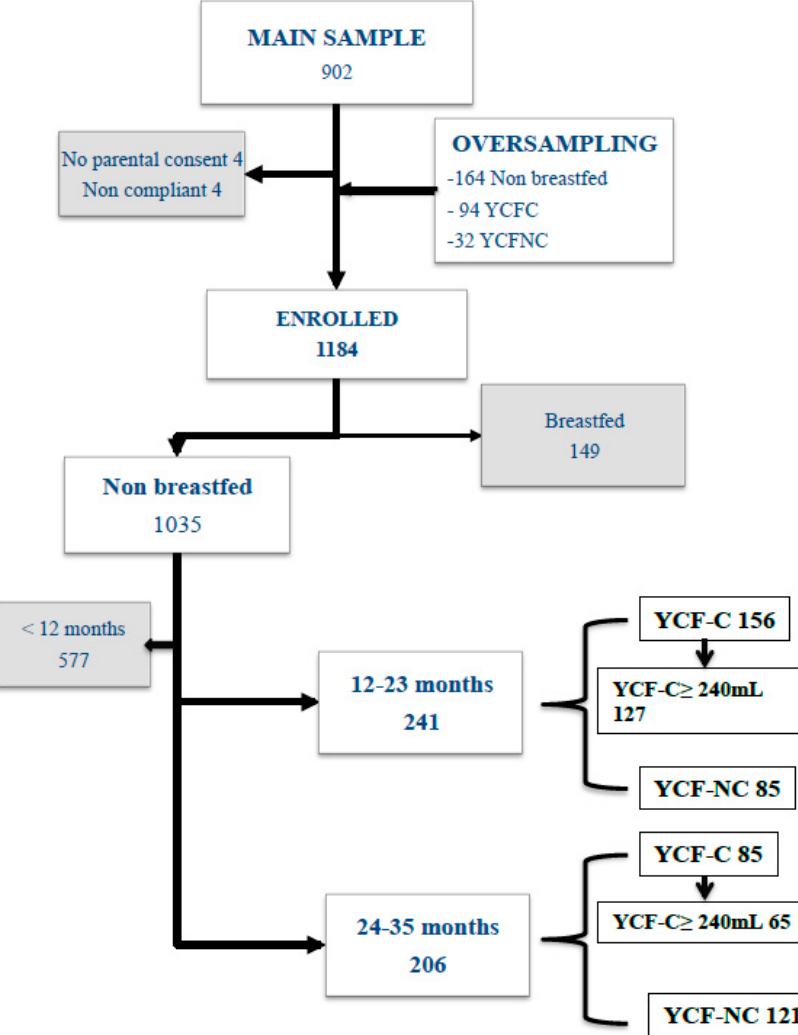
Figure 1. Flowchart of the study sampling to select children consuming young child formula (YCF-C) vs. children who did not consume any formula (YCF-NC).